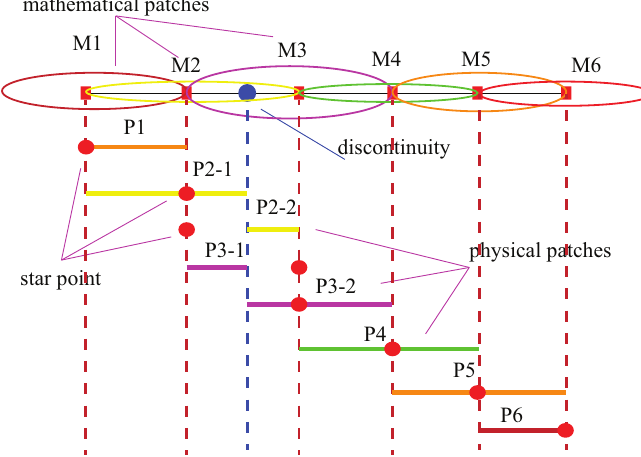
Figure 1. Schematic diagram of 1D NMM with